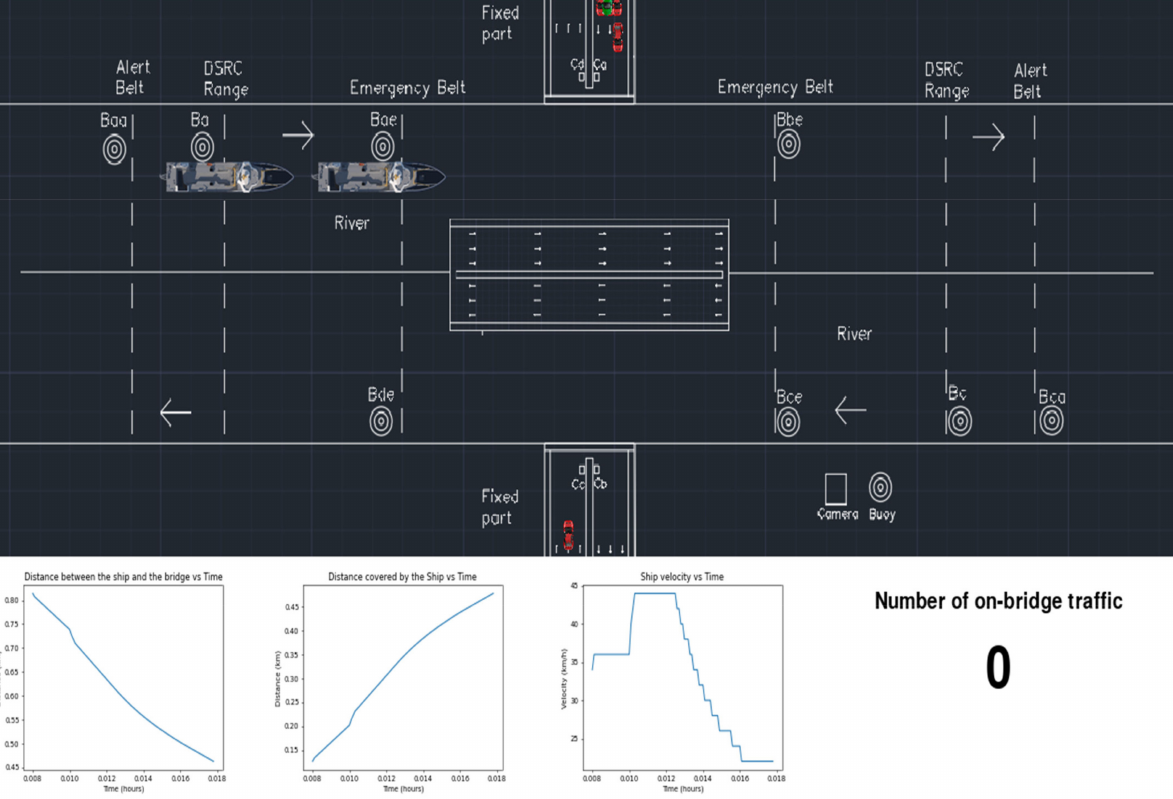
Figure 10. Adaptive Cruise Control among ships at phase